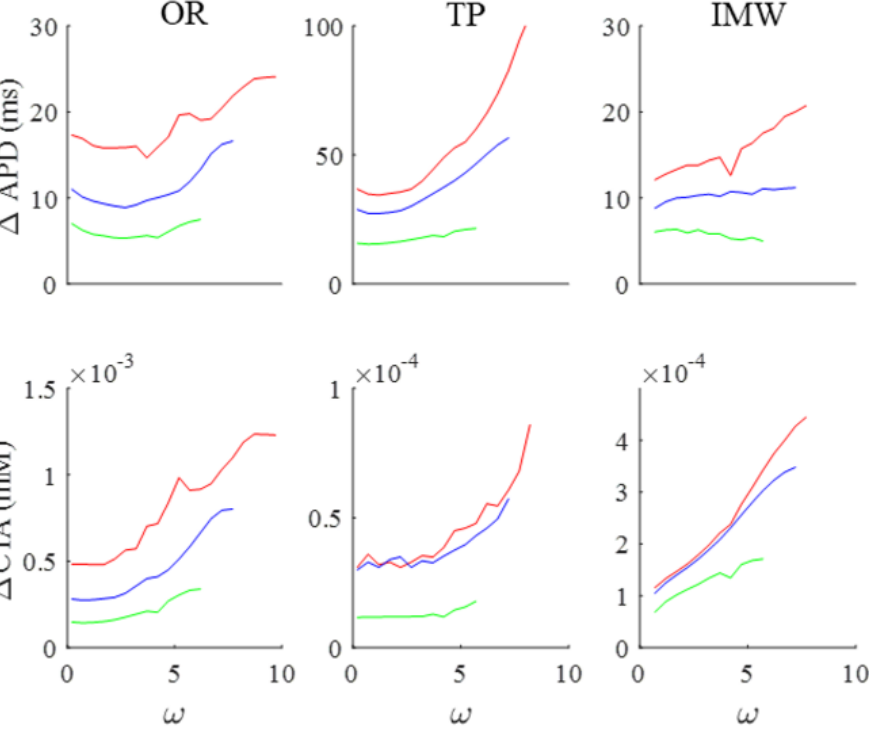
Figure 5. Comparison of three human ventricular AP models. Same representation as in the first column of Figure 4 for the OR, TP, and IMW models. Shortest BCL was 300 ms (OR), 350 ms (TP), and 375 ms (IMW), and is reported in red. Intermediate and long BCL were 400 and 500 ms for all models (blue and green, respectively).